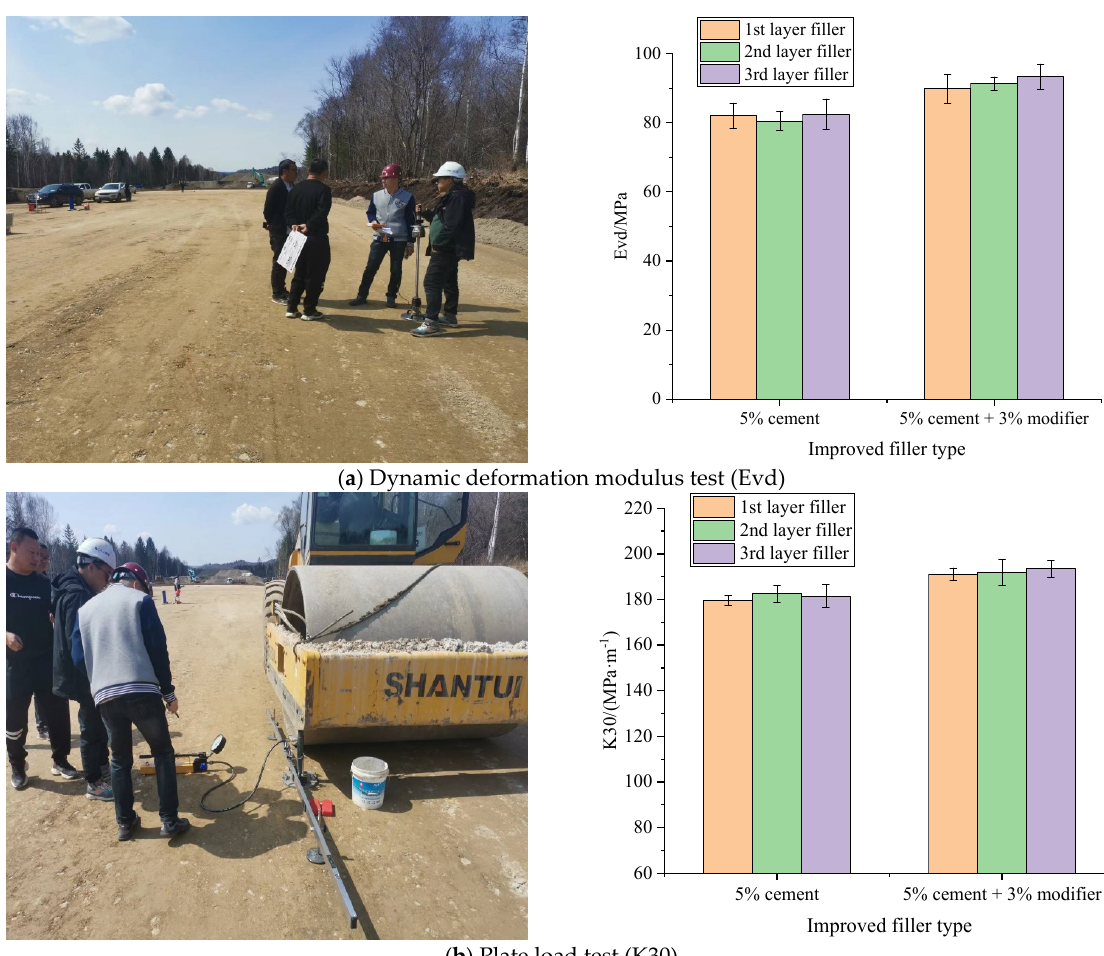
Figure 9. Improved filler dynamic deformation modulus test and plate load test.